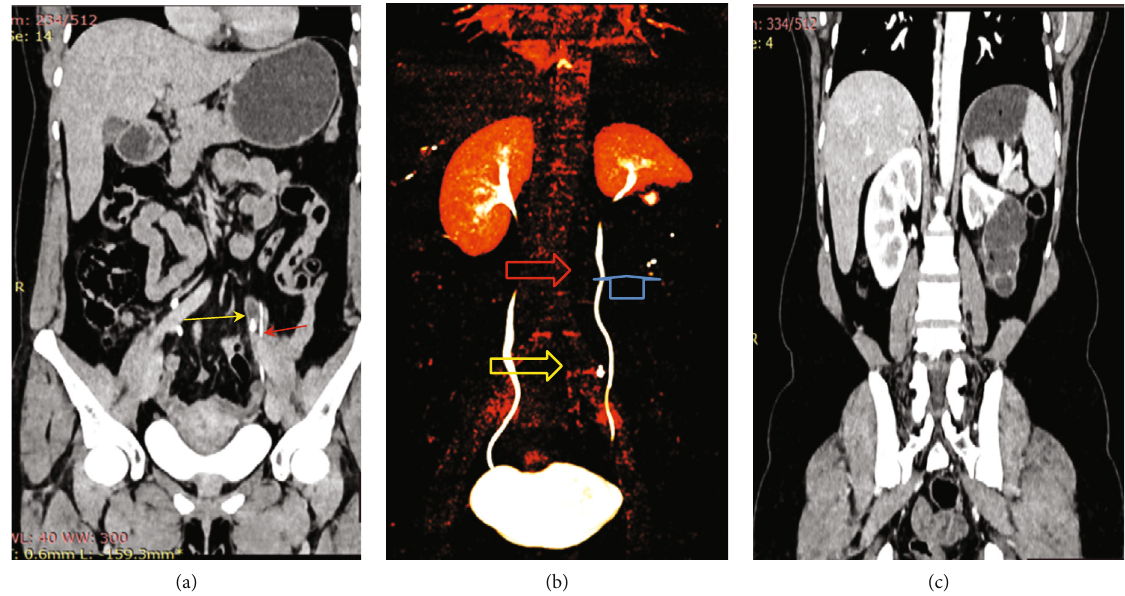
Figure 1: Abdominal CT scan showed the following: (a) coronal view shows both functioning (red arrow) and dilated ureter with proximal dilatation (yellow arrow); (b) 3D CT construction showing midureteric stone (yellow arrow), nonobstructed ureter with complete urinary drainage from upper segment (red arrow), and hydronephrotic segment (blue arrow); (c) contrast fi lm showing lower pole nonfunctioning and hydronephrotic kidney.